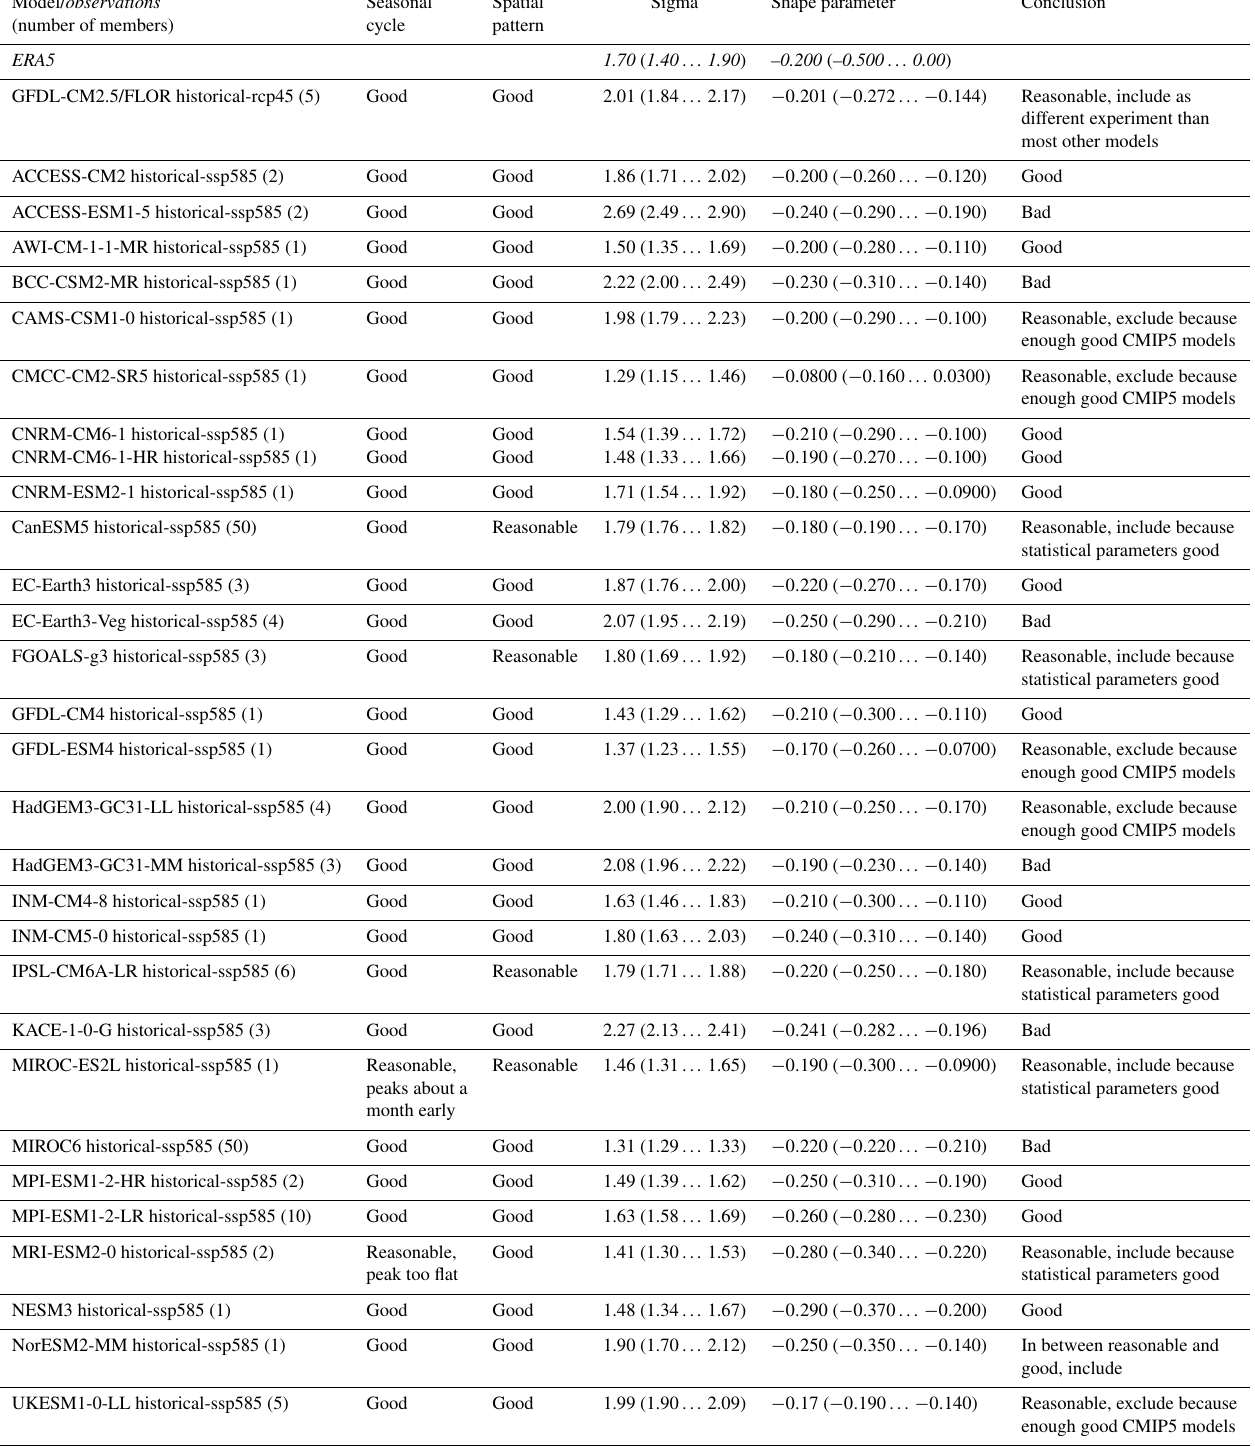
Table A1. As Table 1 but showing all model validation